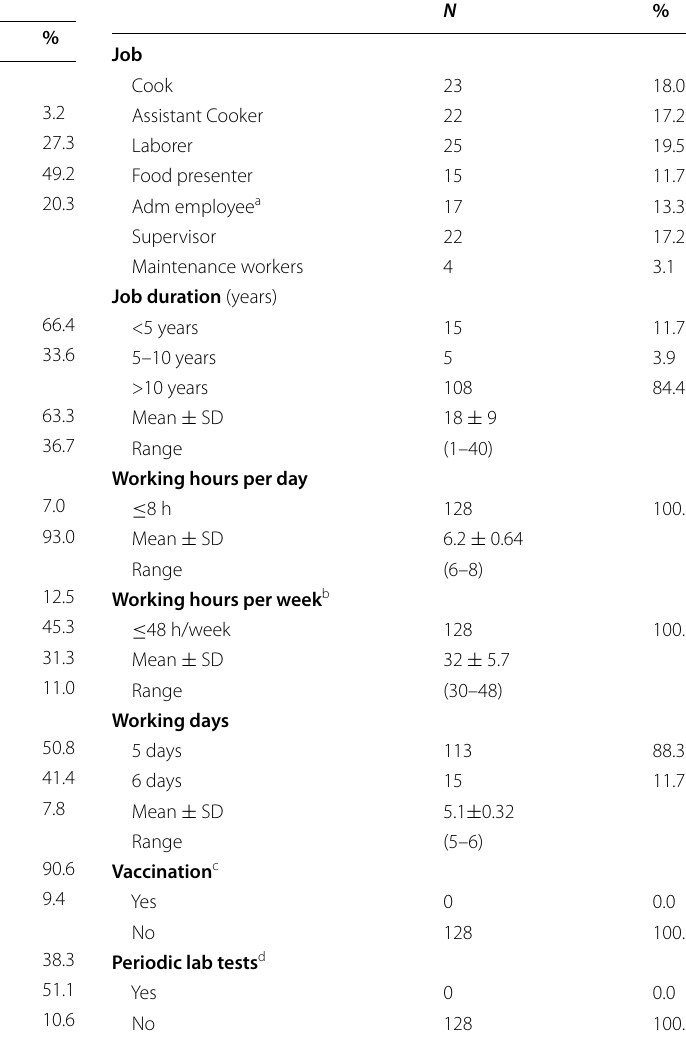
Table 1 Sociodemographic characteristics of the participating Table 2 Job characteristics of the participating kitchen